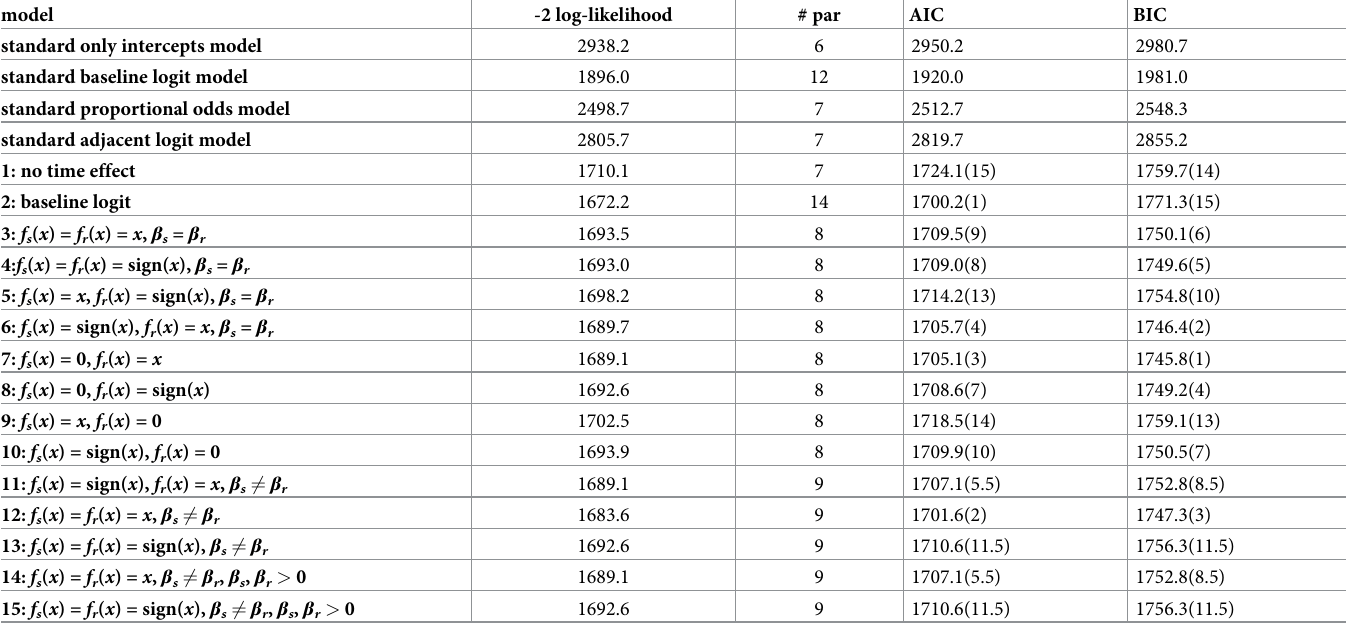
Table 2. The CIPR data: Summary goodness-of-fit statistics for all fitted